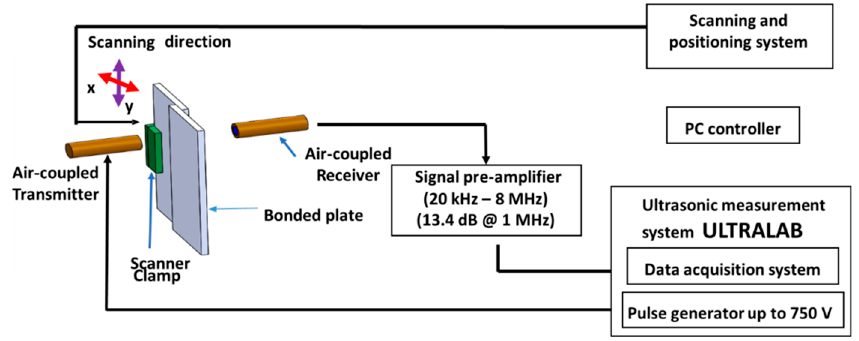
Figure 4. Air coupled through-transmission experimental setup.